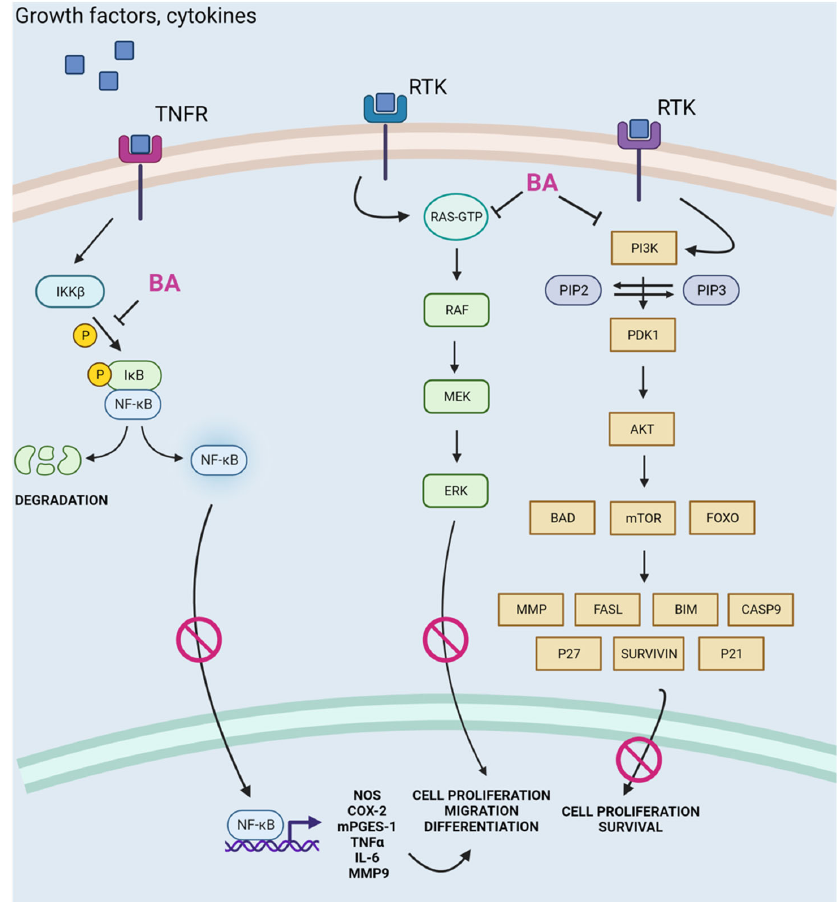
Figure 2. The activation of nuclear factor kappa-light-chain-enhancer of activated B cells (NF- κ B) and the extracellular signal-regulated kinase (ERK)/mitogen-activated protein kinase (MAPK) and phosphoinositide 3-kinase (PI3K)/protein kinase B (AKT) pathways that support the development of the tumor and the pro-inflammatory cellular environment. Phosphorylation of B-cells inhibitor (I κ B) by I κ B kinase (IKK β ) as a result of cellular signals (growth factors, cytokines) received by receptor (tumor necrosis factor receptors (TNFR)), results in heterodimer disconnection, release of NF- κ B, and degradation of I κ B complex component. The released NF- κ B translocates from the cytoplasm to the nucleus, where it acts as a transcription factor responsible for the expression of proteins involved in cell proliferation, migration, and inflammation. The activation of receptor tyrosine kinases (RTKs) initiates activation of ERK/MAPK and PI3K/AKT pathways, promoting survival, migration, and invasion of cancer cells. Binding of the ligand to the RTKs causes the “turning on” of the rat sar- coma virus (RAS) protein through GDP-to-GTP exchange, which activates the RAF proto-oncogene serine/threonine-protein kinase (RAF), mitogen-activated protein kinase (MEK) and ERK kinase, leading to the growth of cancer cells and supporting the transcription of pro-inflammatory factors. Similarly, PI3K is activated via RTKs, which catalyze the phosphorylation of phosphatidylinositol 4,5-biphosphate (PIP2) to phosphatidylinositol (3,4,5)-triphosphate (PIP3). As a result of the interac- tion of PIP3 and phosphatidylinositol kinase (PDK-1), AKT is activated. Being a serine-threonine kinase, AKT phosphorylates numerous proteins involved in the regulation of cell proliferation, growth, and survival. The key substrates for AKT are the mammalian target of rapamycin (mTOR) and the pro-apoptotic factor BCL-2-associated death promoter (BAD), which are capable of inhibiting apoptosis, and nuclear transcription factors fork head box O (FOXO). The use of betulinic acid (BA) prevents the phosphorylation of I κ B, and thus, the release and translocation of NF- κ B into the nucleus. As a consequence, the expression of inflammatory mediators and enzymes is not induced. BA also inhibits the activation of ERK/MAPK and PI3K/AKT signaling pathways, suppressing mechanisms oriented toward tumor growth and development. Created with